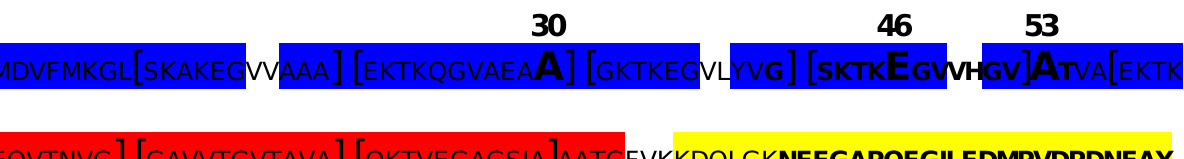
Figure 1. Alpha-synuclein’s sequence and domains. Blue highlighted: four α -helices responsible for protein-membrane interactions. Red highlighted: NAC or non-A β (amyloidogenic) component of α -syn, responsible of protein-protein interactions. Yellow highlighted: the unstructured C-terminal domain. Exons that undergo alternative splicing are indicated in bold: exon 3 from codon 41 to 54 and exon 5 from codon 103 to 130. Mutations A30P, E46K and A53T are in bold and enhanced. The seven 11 aa repeats are shown between the square brackets